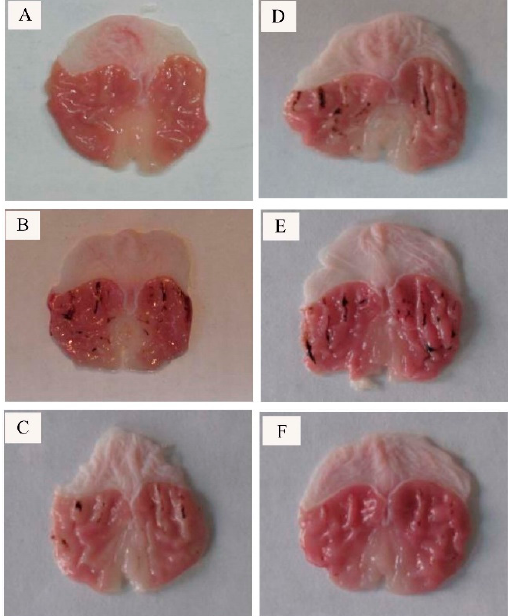
Figure 5 . Morphological appearance of different treatments against ethanol-induced gastric lesions.